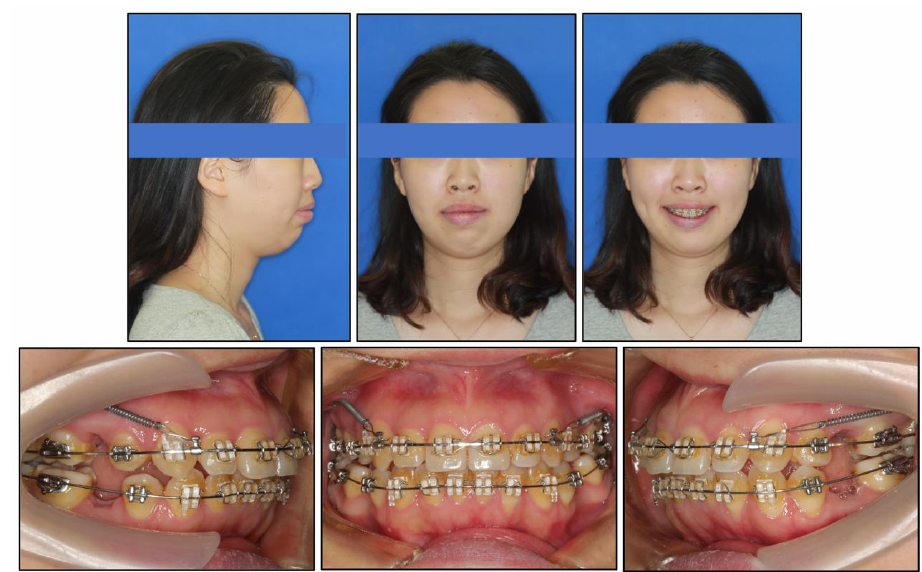
Figure 4. Eight months into treatment, effective alignment and leveling in both arches. Then, two miniscrews on the maxillary posterior segment were used to retract anterior teeth.